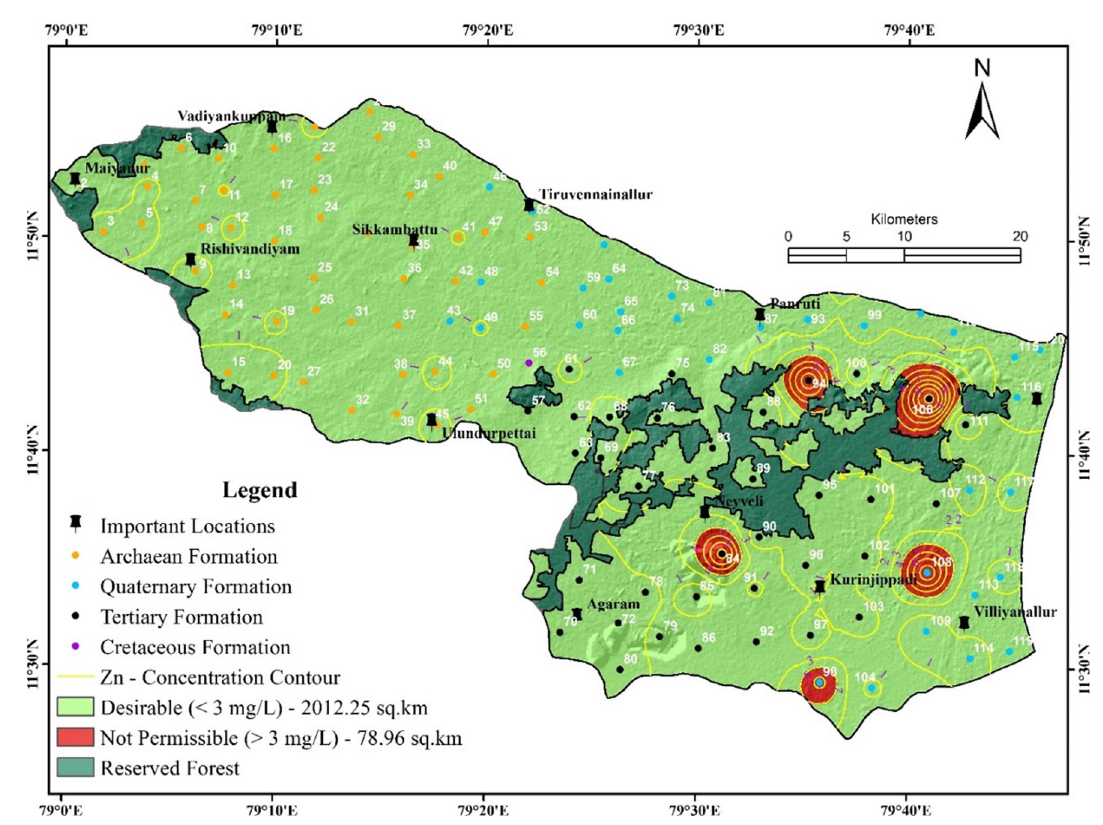
Fig. 6 Spatial variation with contour map of zinc in